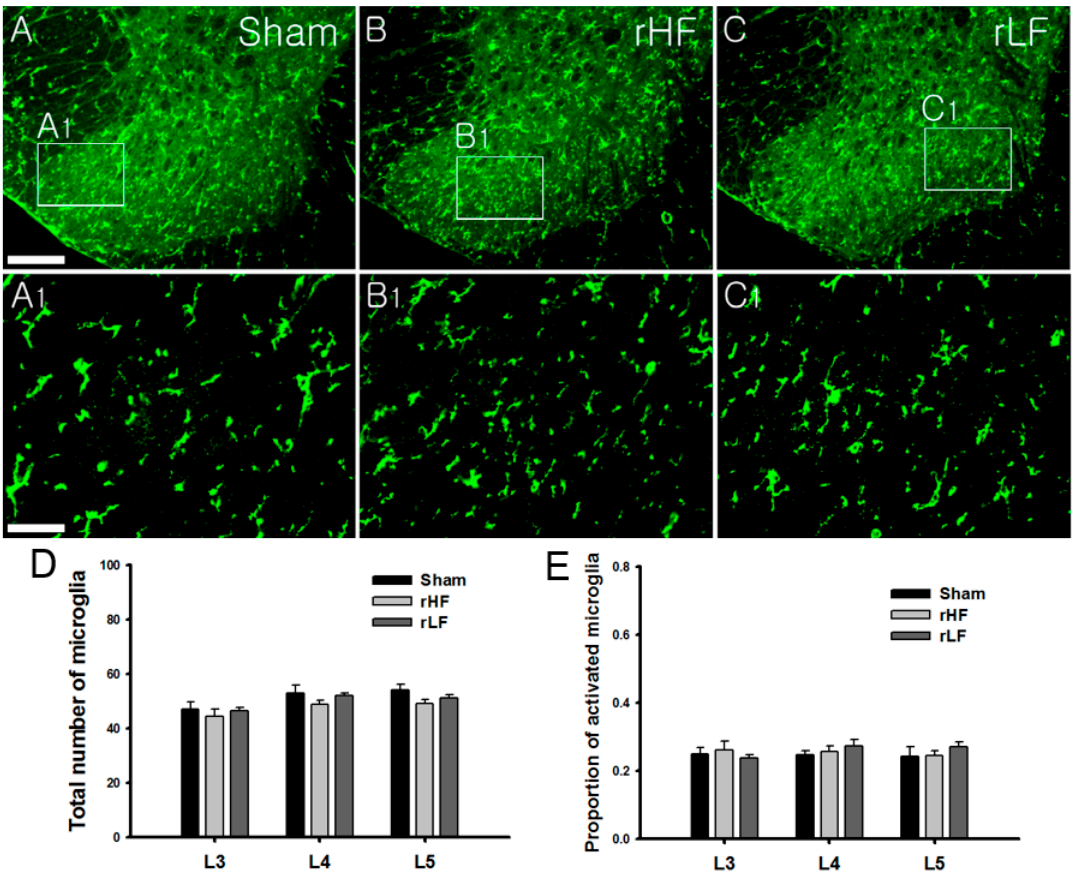
Figure 3. Changes in the expression of spinal microglia after repeated transcutaneous electric nerve stimulation (TENS) applications ( A , A 1 ) The expression of activated microglia was exhibited after repeated sham TENS application. Moreover, repeated high-frequency (HF) TENS ( B , B 1 ) and repeated low-frequency (LF) TENS ( C , C 1 ) showed the expression of the activated microglia in the spinal cord. ( D , E ) HF and LF TENS did not significantly change the proportion of activated microglia and the total number of microglia expressed in the L3–L5 segments compared with sham TENS. Scale bar: ( A – C ) 200 μ m and ( A 1 , B 1 , C 1 ) 50 μ m.